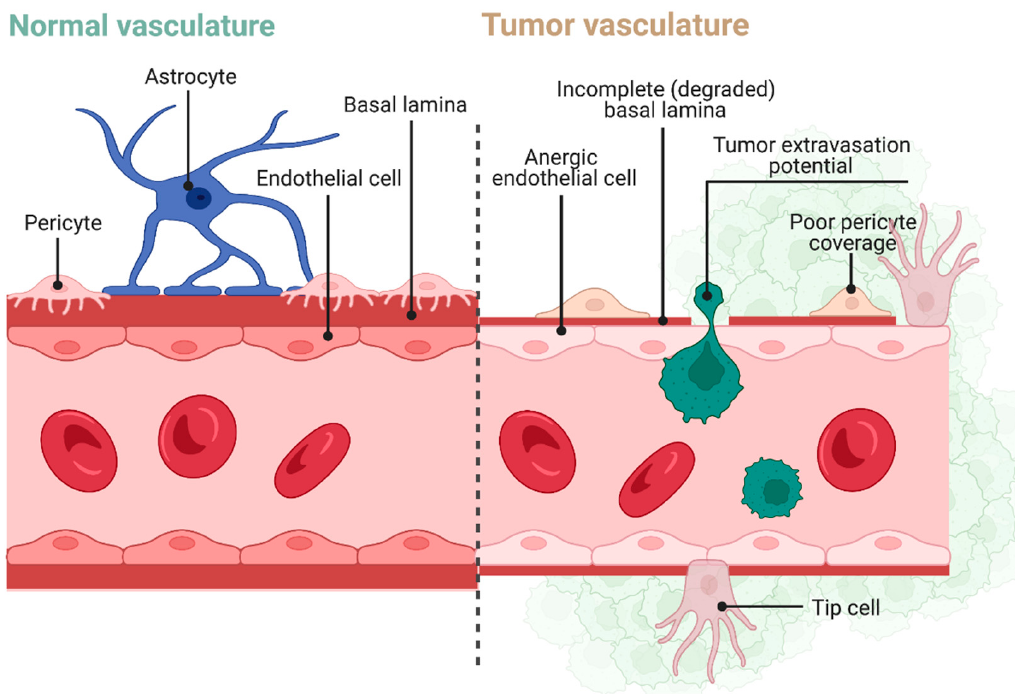
Figure 2. The left panel shows the normal anatomy of the blood–brain barrier in which tight junctions exist between endothelial cells to prevent the passage of most therapeutics into the brain parenchyma. This basic structure is supported by astrocytes and pericytes, which help maintain and regulate these tight junctions. The right panel shows the pathology of the BBB induced by tumor growth. For one, there is increased permeability of the endothelial cells’ tight junctions, permitting tumor cell extravasation. There is an atrophied basal lamina, which contributes to anergic endothelial cells. Finally, pericytes are both fewer and display an abnormal morphology. The combination of these factors can promote tumor migration and growth. Created with BioRender.com.